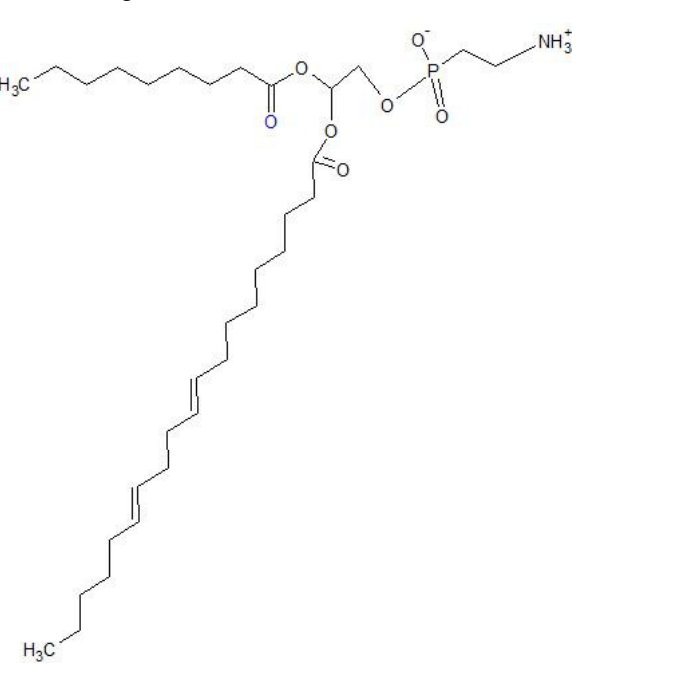
Figure 2. Soy lecithin—chemical structure.